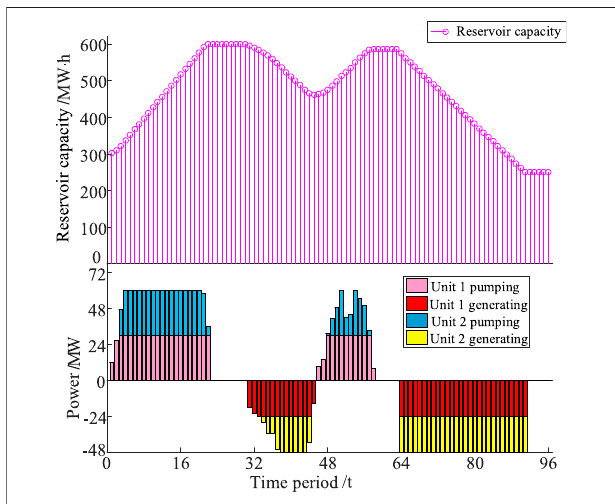
FIGURE 10 | Reservoir capacity and unit output curve of Case 3.